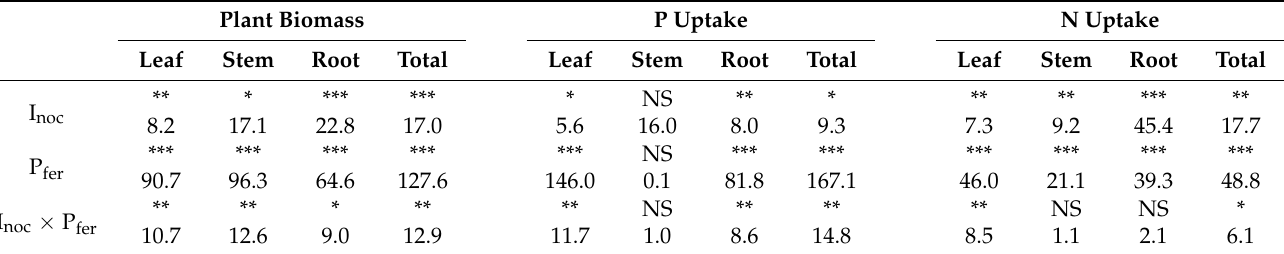
I noc and P fer indicate the effect of Rhizobium inoculation and P fertilizer. NS, *, **, and *** indicate not